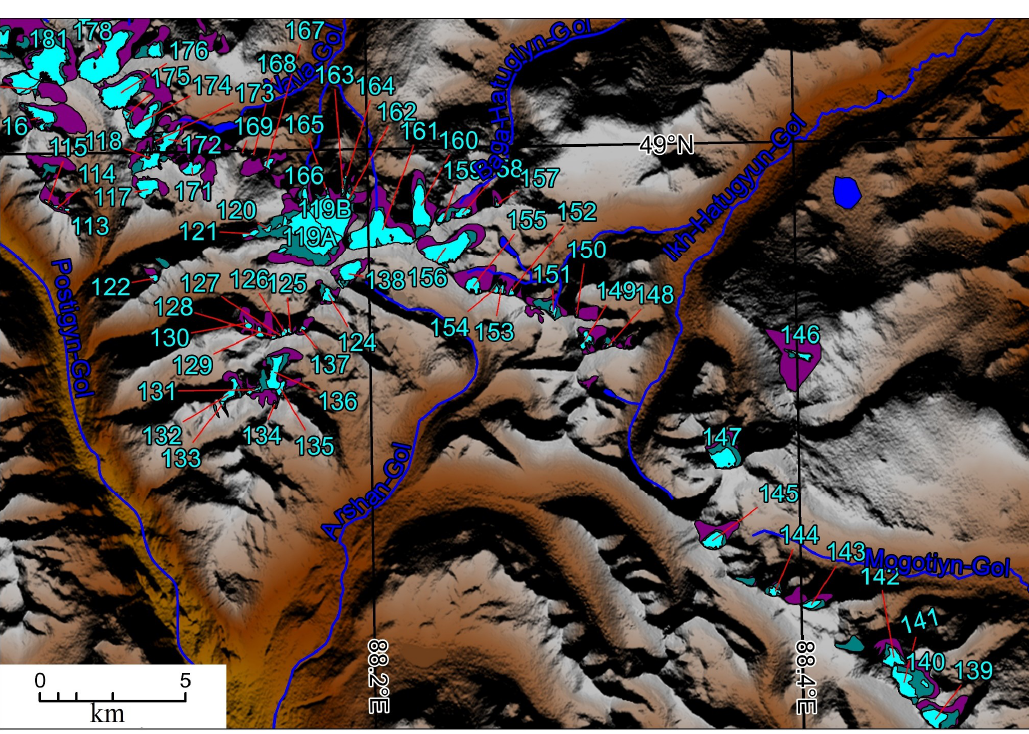
Figure 14. Glacial shrinkage after the LIA maximum in the south‑east of Tavan Bogd.